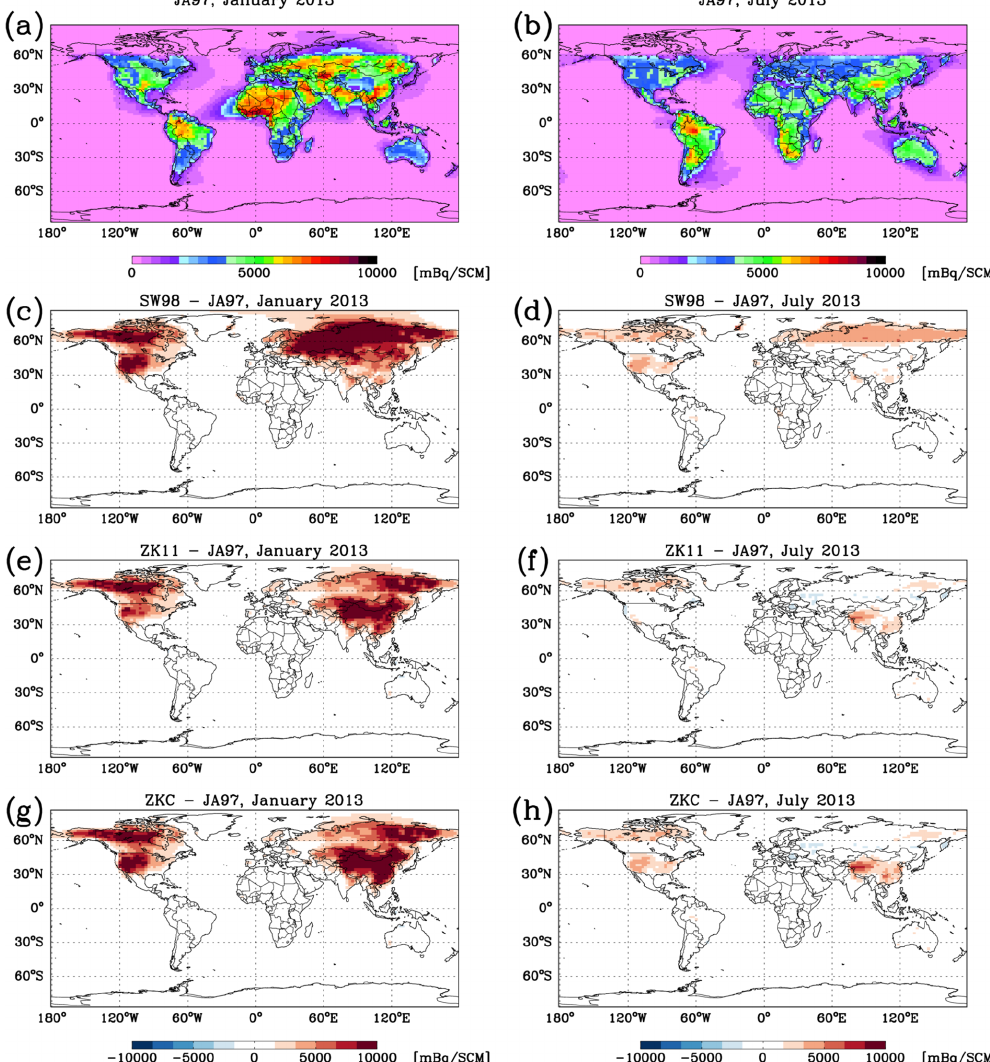
Figure 5. Simulated monthly surface 222 Rn concentrations (mBq/SCM) for (a) January 2013 and (b) July 2013 with the JA97 emission scenario (A1; see Table 2). Panels (c) – (h) are the same as panels (a) and (b) but show the changes in surface 222 Rn concentrations when SW98 (A2), ZK11 (A3), and ZKC (A4) emissions are used in the model,